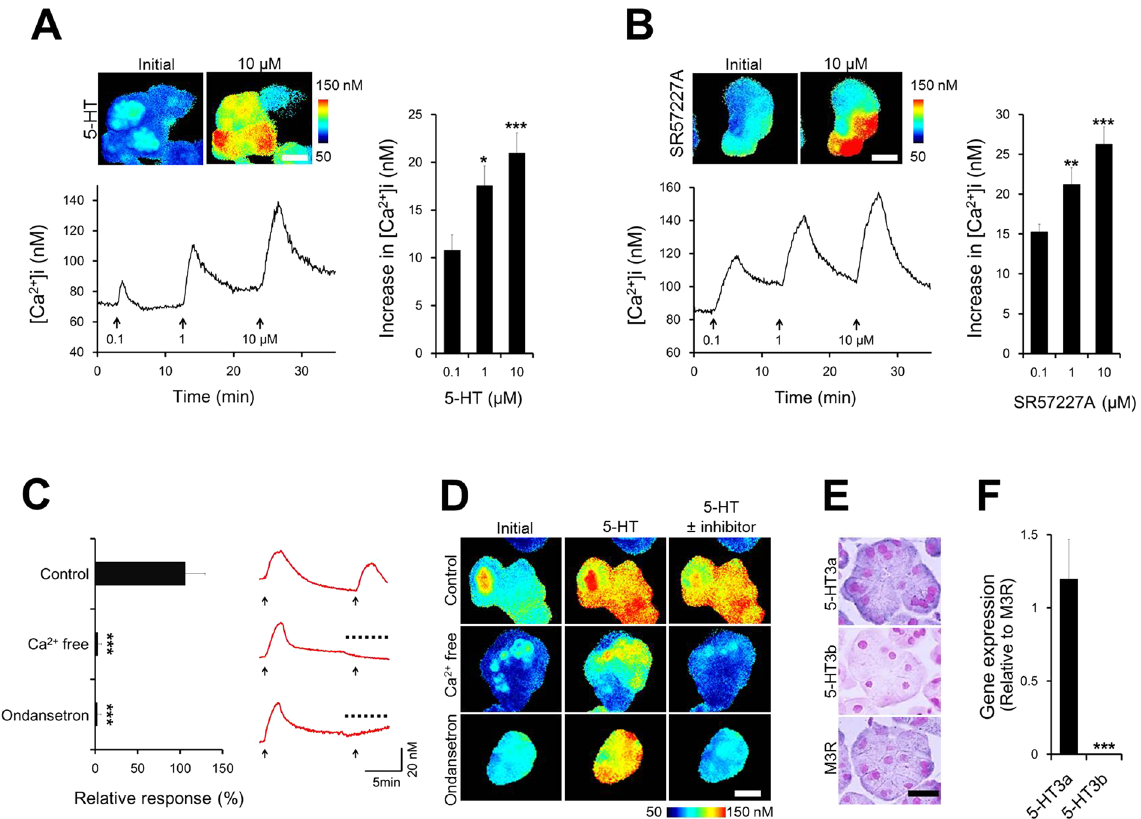
Figure 5. 5-HT mobilizes [Ca 2 + ]i in lacrimal gland acinar cells via 5-HT3aR. Intracellular calcium mobilization was measured in fura-2 loaded LG acinar cells isolated from normal rat. Changes in [Ca 2 + ]i in LG acinar cells by stimulation with ( A ) 5-HT and ( B ) SR57227A. The upper panel shows pseudo-colored images of [Ca 2 + ]i before stimulation (left) and after stimulation with 5-HT or SR57227A at a dosage of 10 µ M (right) (scale bar, 50 µ m). The lower trace shows the typical response to each stimulus. The arrow indicates the time at which 5-HT or SR57227A was applied to the cells. The bar chart shows the summarized data of amplitudes of [Ca 2 + ] i responses ( A : n = 43 acini, B: n = 49 acini). ( C ) Inhibitory effects of ondansetron and a Ca 2 + -free condition on 5-HT-induced [Ca 2 + ]i mobilization (n = 11–25 acini). Representative responses obtained under each condition (red trace). The arrow indicates the time at which 5-HT was applied to the cells at dosages of 0.1, 1, and 10 µ M, respectively. The dotted line over the trace indicates the presence of an antagonist or a Ca 2 + -free condition. Relative responses were calculated as a percentage of the decrease in the 5-HT-induced [Ca 2 + ]i response with the application of a Ca 2 + -free condition or ondansetron relative to the stimulation induced with 5-HT alone in each acinus. Pseudo-colored images of [Ca 2 + ]i are shown in ( D ); the scale bar is 50 µ m. Gene expression analysis of the 5-HT3R subtype detected by ( E ) ISH (counterstain: nuclear fast red, scale bar: 10 µ m) and ( F ) determined by qPCR (n = 6 LG). mRNA expression of the 5-HT3R subtype was determined in normal rat LG. ISHs are shown for the indicated 5-HT3R and M3R probes ( E ). Each panel shows LG acinar cells. All data represent the mean ± SD. * P < 0.05, ** P < 0.01, *** P < 0.001 versus 0.1 µ M ( A , B ) and versus 5-HT3a ( F